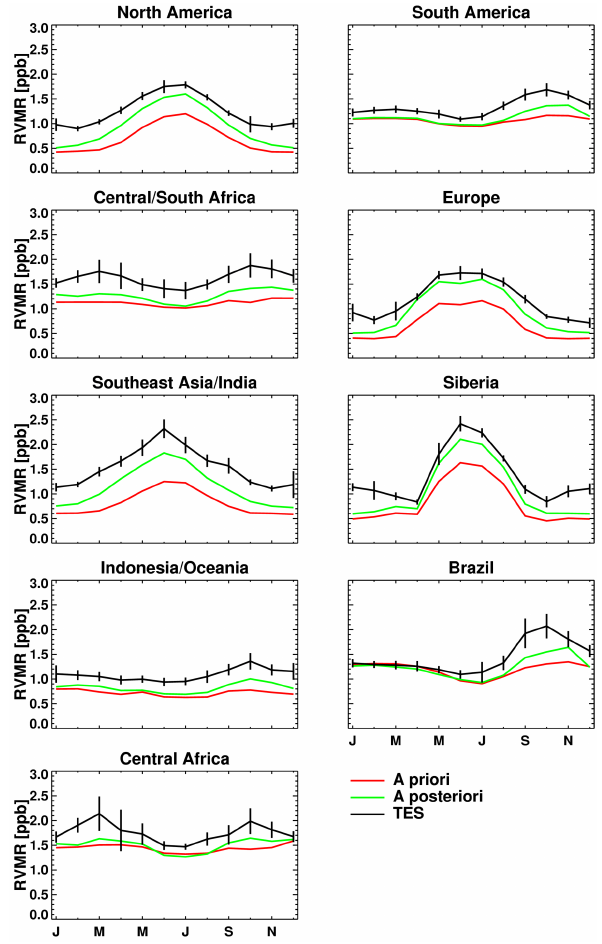
Fig. 7. Time lines of monthly-mean representative volume mixing Figure 7. Timelines of monthly-mean representative volume mixing ratio (RVMR) as measured 2 ratio (RVMR) as measured by TES (black) and simulated by GEOS- by TES (black) and simulated by GEOS-Chem, averaged over the regions in Fig. S4. The vertical 3 Chem, averaged over the regions in Fig. S4. The vertical black lines black lines correspond to the ±95% confidence interval of the TES monthly means. The red line 4 correspond to the ± 95% confidence interval of the TES monthly means. The red line is the a priori GEOS-Chem simulation, and the green line is the a posteriori simulation with optimized terrestrial